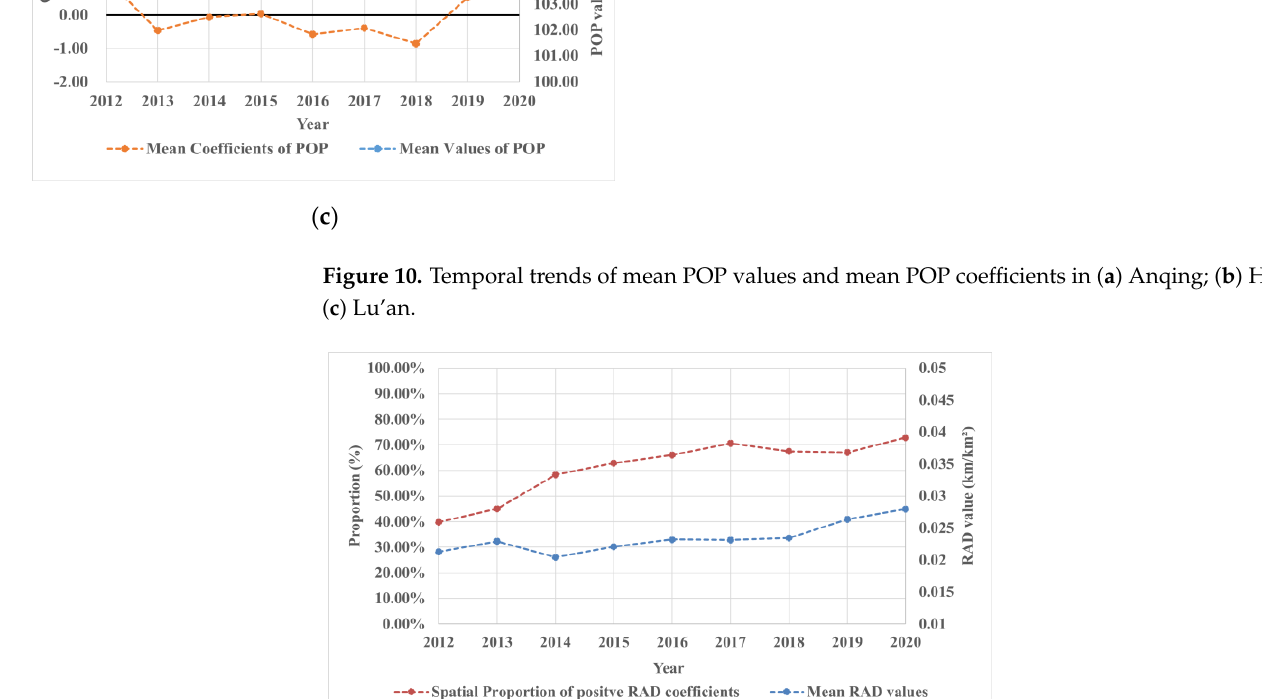
Figure 10. Temporal trends of mean POP values and mean POP coefficients in ( a ) Anqing; ( b ) Hefei; ( c ) Lu’an .